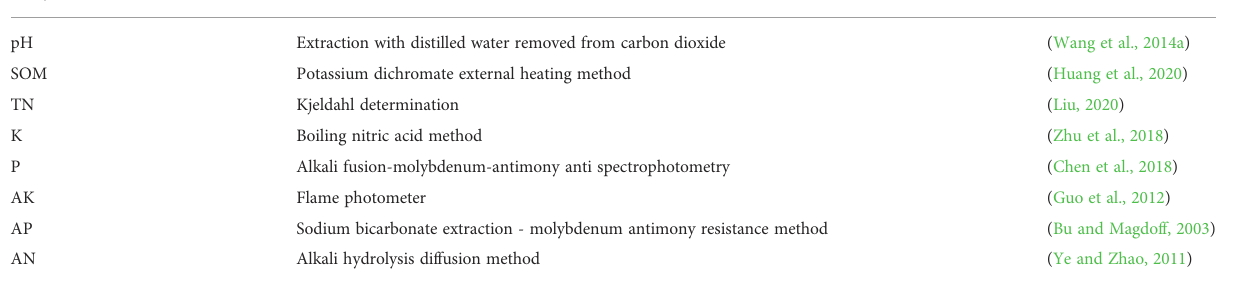
TABLE 1 Soil physical and chemical properties and determination